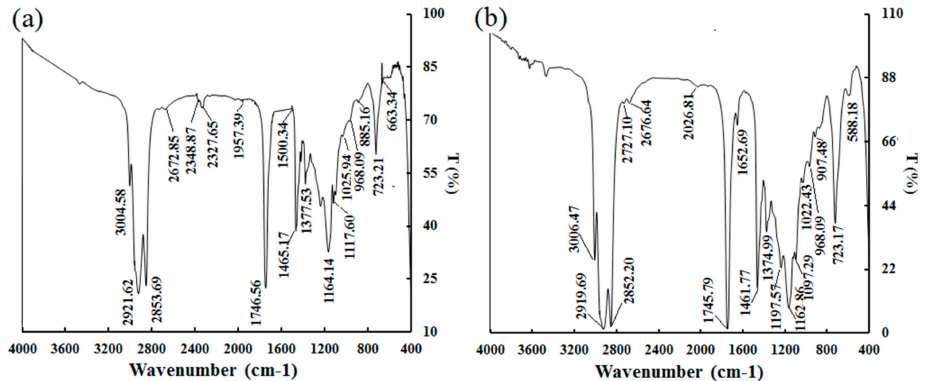
Figure 5. FT-IR spectra of B. dasystachya seed oil obtained using di ff erent methods: ( a ) The supercritical carbon dioxide (SC-CO 2 ) extraction method; ( b ) The petroleum ether extraction (PEE)